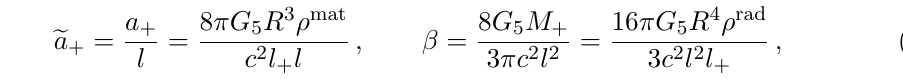
M = 3 (cid:25)l 2 = 4 = 100 in the (cid:12)gure 6. For su(cid:14)ciently small 5 + ; a ) = (0 ; 0) are preferable and as a (cid:0) (cid:0)